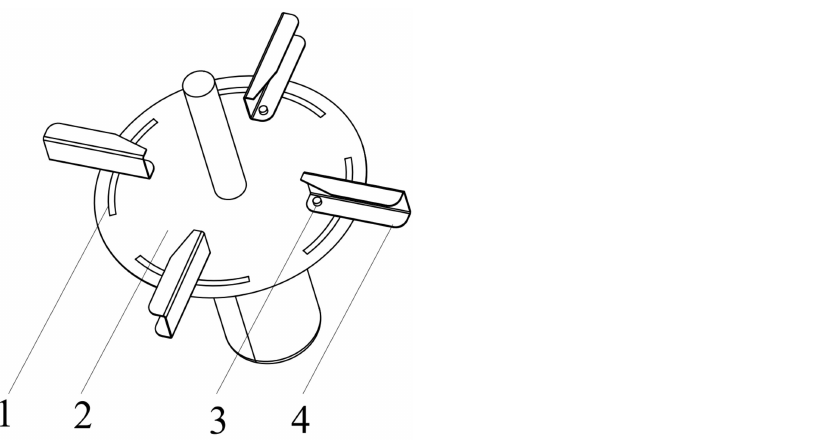
Figure 4. Structure schematic of the centrifugal disc. (1) Vane, (2) output of the distribution cover, (3) chute, and (4) adjustment